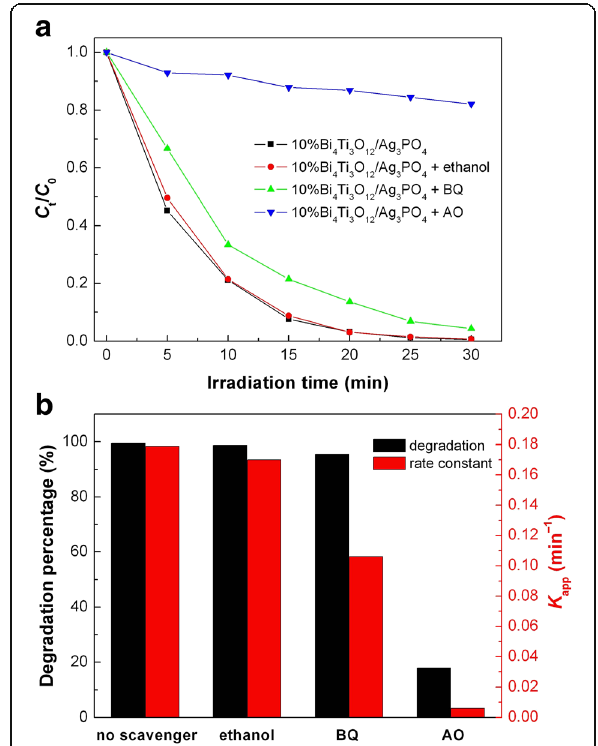
Fig. 10 Effect of ethanol, BQ, and AO on the RhB degradation over 10% Bi 4 Ti 3 O 12 /Ag 3 PO 4 . a Time-dependent photocatalytic degradation of RhB. b Degradation percentages of RhB after 30 min of photocatalysis and first-order reaction rate constants k app